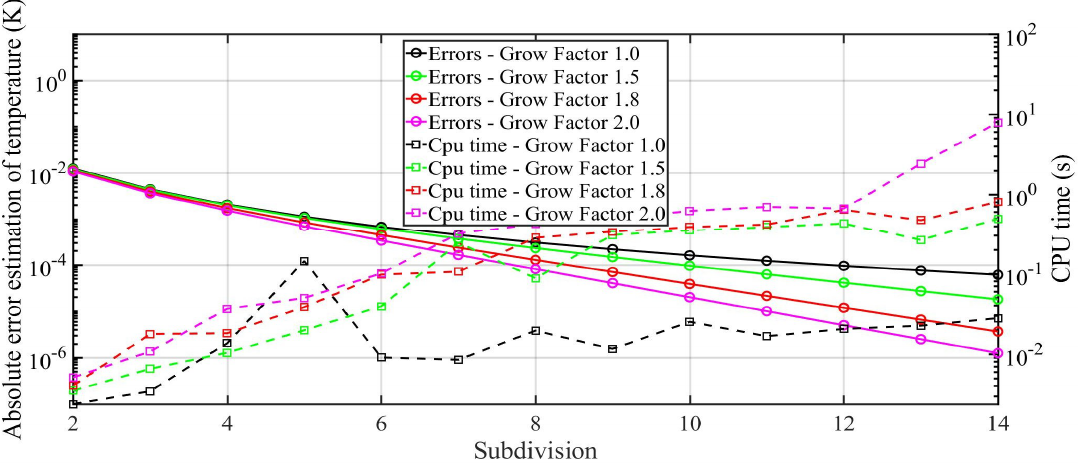
Figure 12. Absolute maximum temperature error estimations of the inner surface (Case 2).